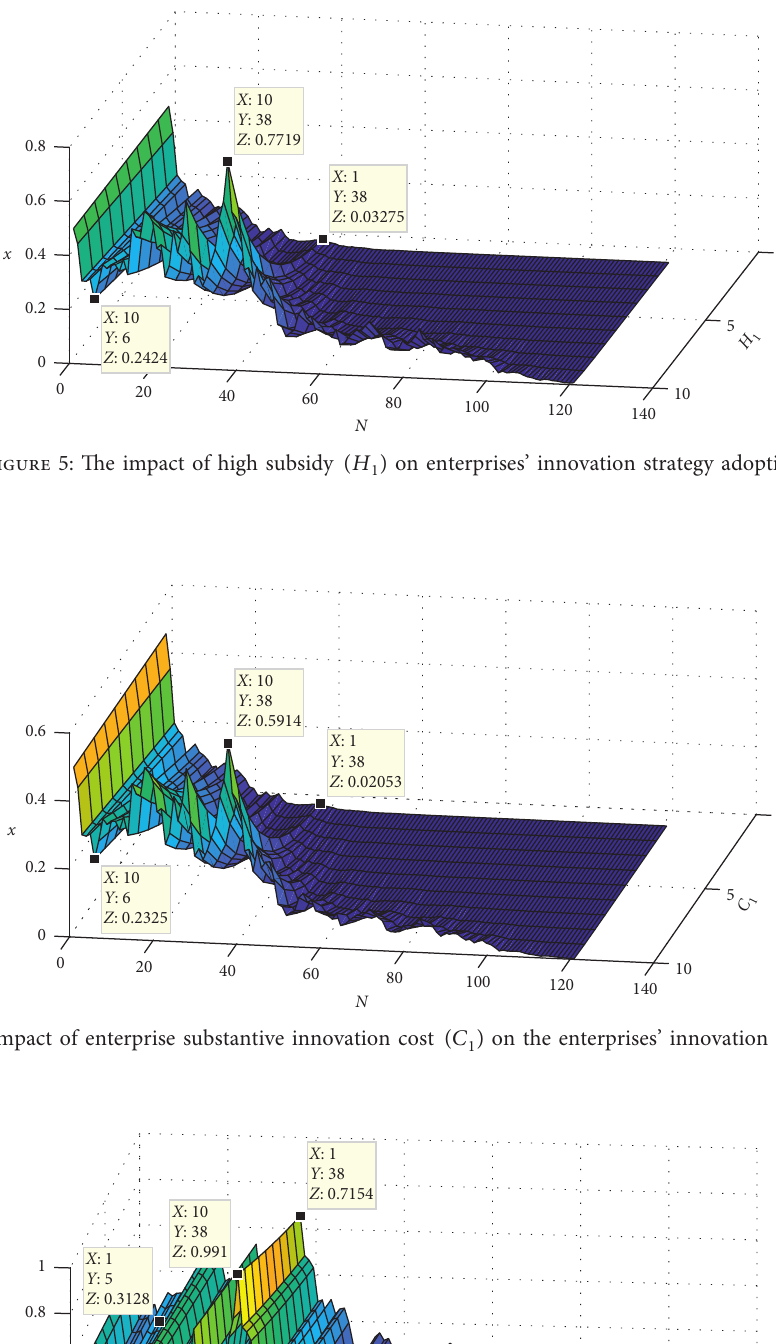
Figure 7: The impact of reputation damage ( δ T ) on the local governments’ innovation strategy